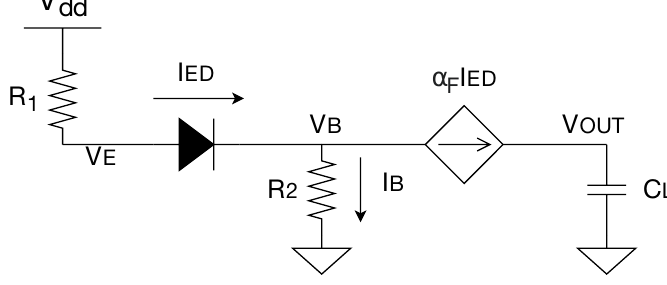
Figure 5. Equivalent circuit for the proposed sensor when V IN =